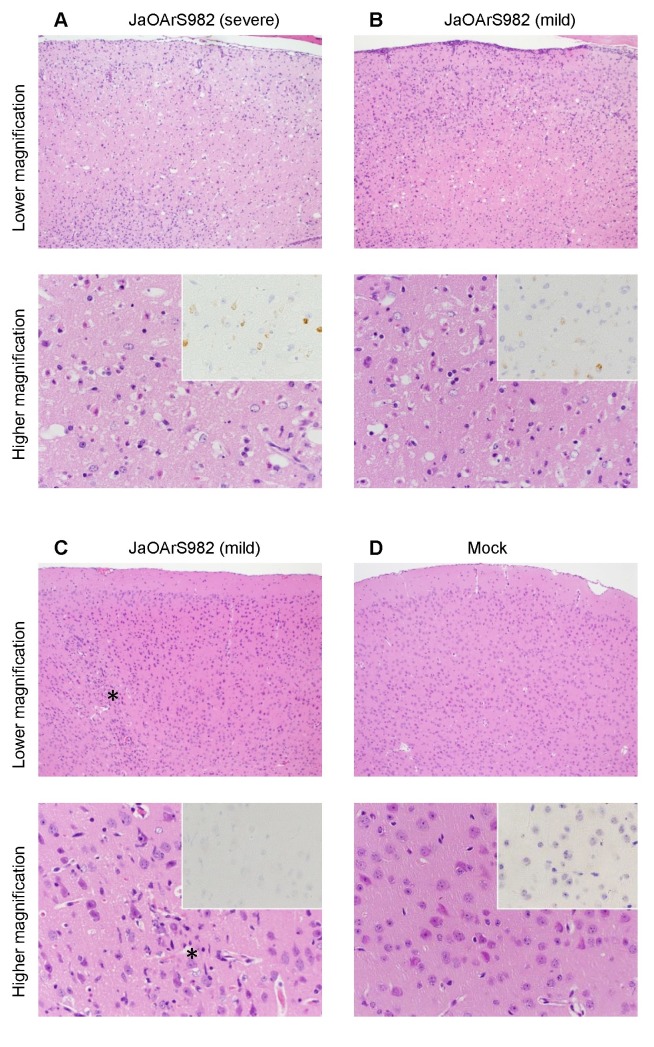
Histopathological features of brain cortex in severe and mild cases of JaOArS982-infected B6 mice.Histopathological features of B6 mice infected with 104 pfu of JaOArS982 at 13 days pi. Each experiment represents five and sixteen mice of severe and mild cases, respectively. JEV antigens were detected using E-protein specific JEV antibody (insets). (A) Severe case (weight ratio: 0.63) showed acute neuronal necrosis in the brain cortex. Virus antigen-positive cells were the necrotic neurons. (B) In a mild case (weight ratio: 0.90), massive inflammatory infiltration was exhibited. Acute necrosis was seen in the area. Some JEV antigen-positive cells were detected. (C) In a mild case (weight ratio: 1.05), focal inflammatory infiltration was seen in the brain cortex (asterisk). JEV antigens were not clearly detected. (D) Mock-infected mice (weight ratio: 1.02).